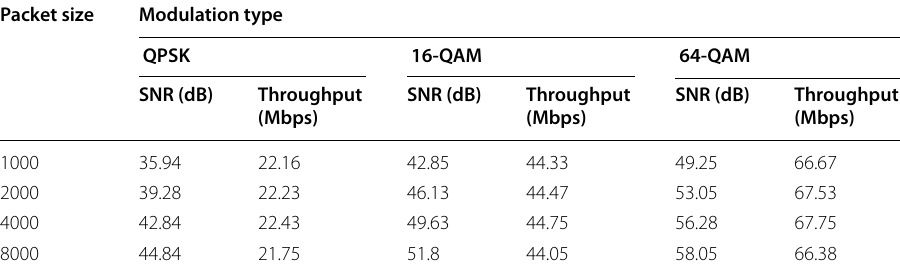
Table 5 SNR and corresponding throughput values for various packet sizes in the CLLA model Packet